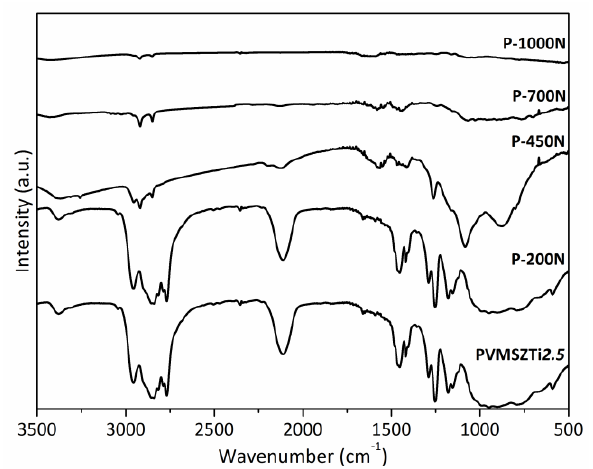
Figure 7. FTIR spectra of pyrolysis intermediates isolated in flowing nitrogen and derived from PVMSZTi 2.5 .